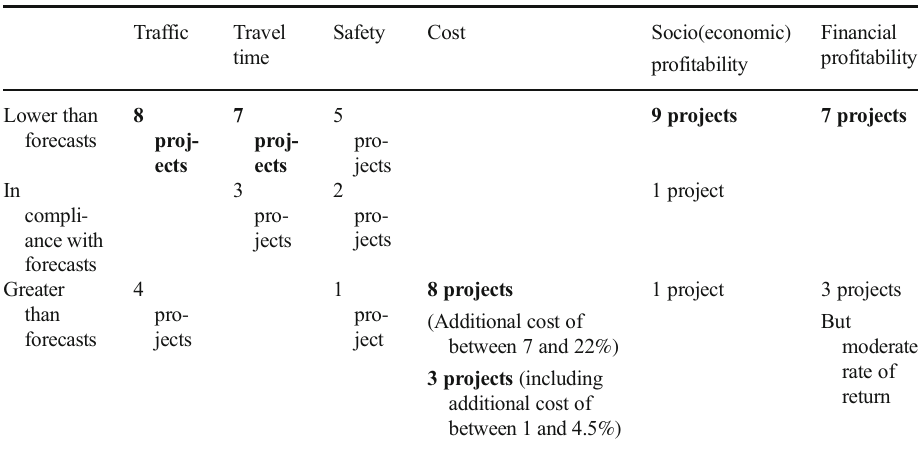
Table 5 Synthesis of the comparison between forecasts (final draft design files) and the results attained by the constructed infrastructures(traffic, travel time, safety, cost and